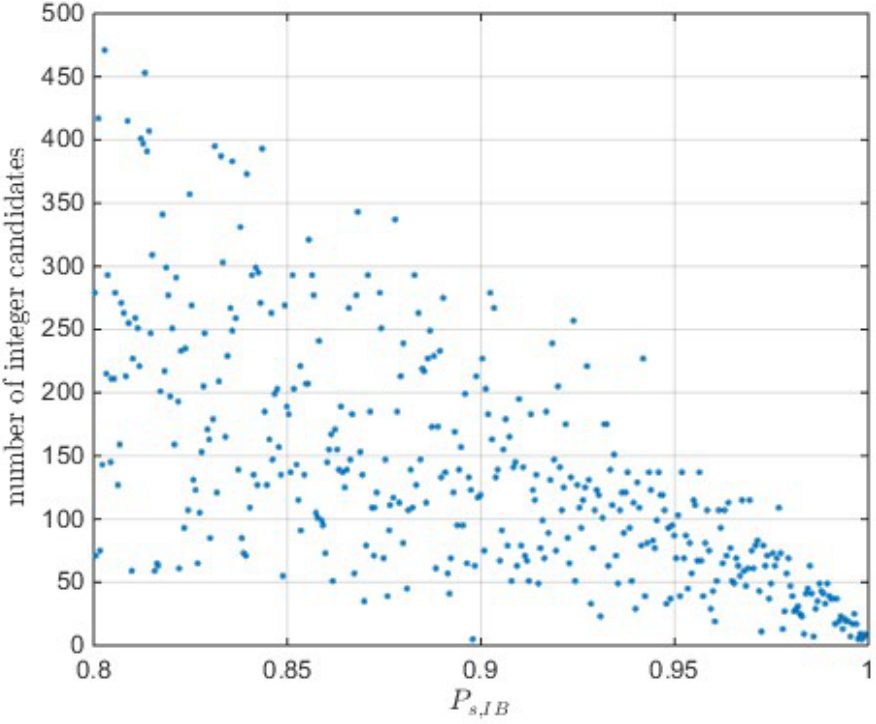
Figure 1. Number of integer candidates in the trust region with significance Figure 1 . Number of integer candidates in the trust region with significance level.